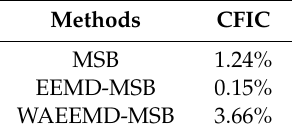
Table 2. The characteristic frequency intensity coe ffi cient (CFIC) of conventional MSB, EEMD-MSB, and